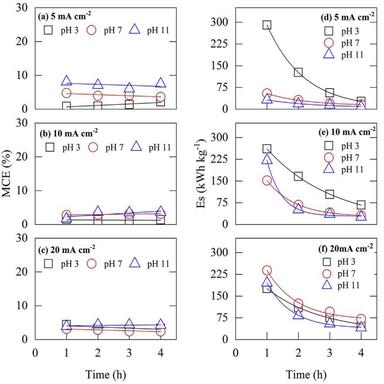
Mineralization current efficiency (a, b and c) and specific energy consumption (d, e and f) for all experimental conditions. EAO conditions: 50 mg L1 of PRED, 1 g L1 of Na2SO4, room temperature and no pH control.